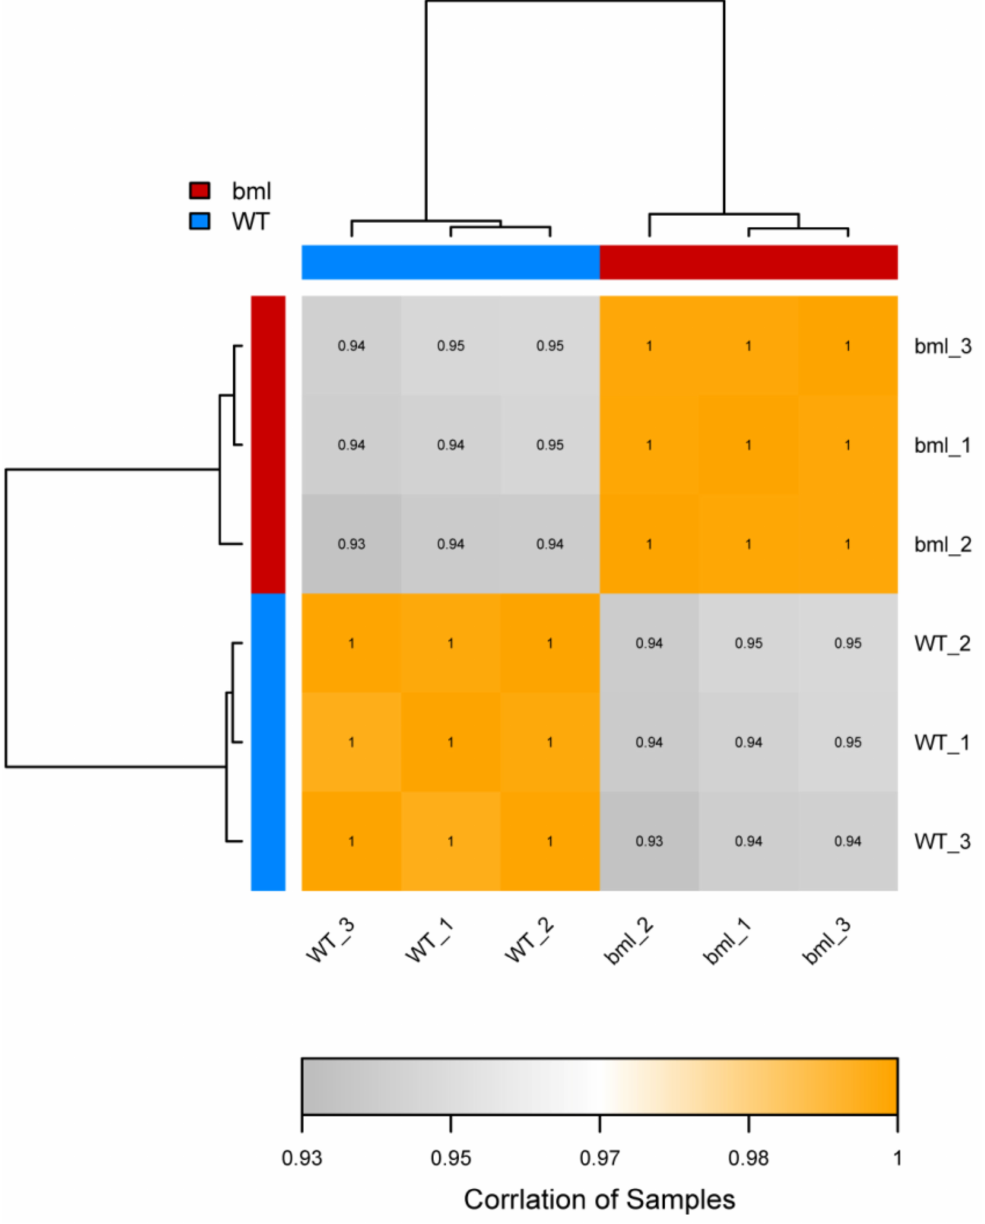
Figure 2. Heat-map diagram of inter-sample correlation analysis. The color block represents the correlation index value. The grayer the color, the lower the correlation index between samples and higher intensity of the color represents the higher correlation